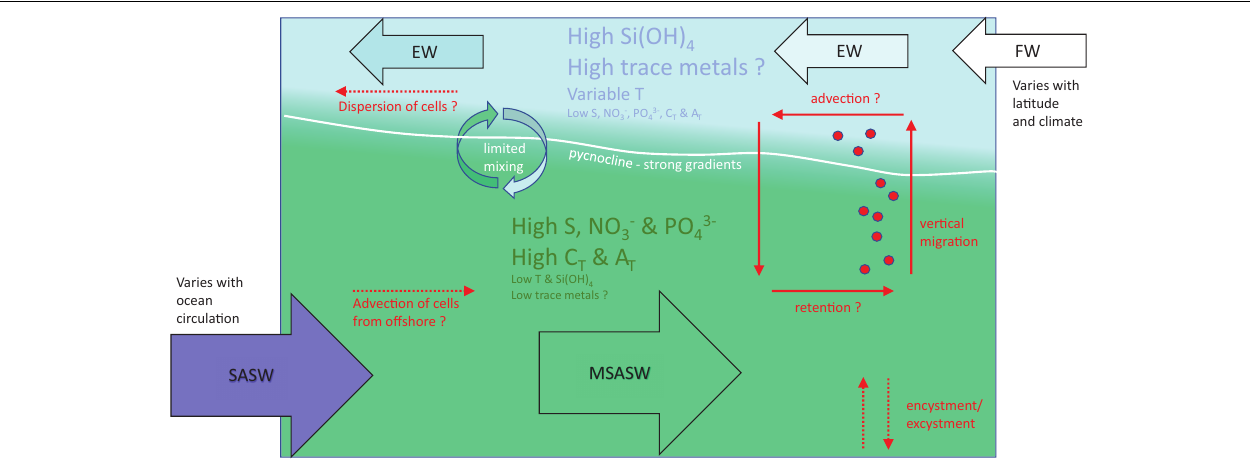
FIGURE 7 | Schematic diagram of the generalized structure of the water column in the fjords and channels of Chilean Patagonia and Tierra del Fuego, indicating the principal processes that potentially influence populations of the dinoflagellate A. catenella . Subantarctic surface water (SASW) flows into coastal waters and forms modified subantarctic water (MSAW) through the interaction with estuarine water (EW). MSAW is overlain by a near-surface layer of EW fed by input of continental freshwater (FW) derived from precipitation, streamflow and glacier melt; the resulting pycnocline reduces mixing between the two layers. Temperature (T) is variable in FW and EW, which are high in silicic acid (Si(OH) 4 ) and potentially in dissolved trace metals (few data available), but low in salinity (S), nitrate and phosphate (NO 3 - and PO 43 - ), total CO 2 (C T ) and total alkalinity (A T ). SASW and MSAW are high in S, NO 3 - , PO 43 - , C T and A T , but low in T, Si(OH) 4 , and dissolved trace metals. Vertical distribution is not well described for these waters, but A. catenella is thought to aggregate close to the pycnocline where it can optimize vertical position within strong gradients of T, S, irradiance, macro- and micro-nutrients, dissolved CO 2 , and potentially turbulence. Gradients of pH and pCO 2 (not indicated) within the pycnocline – and in the surface layer – will be driven by the strong gradients in C T and A T , and by air-sea exchange of gaseous CO 2 . Physical retention of A. catenella within certain fjords and channels could be promoted by vertical migration patterns within the two-layered flow. Encystment and excystment processes ensure recurrence of A. catenella under favorable conditions. Advection of A. catenella into coastal waters and dispersal of cells within the upper EW layer are major unknowns in Chilean waters. The above diagram represents a broad schematic description that depends on relative inputs of SASW and FW and associated properties; local patterns vary with ocean circulation, latitude, and climate